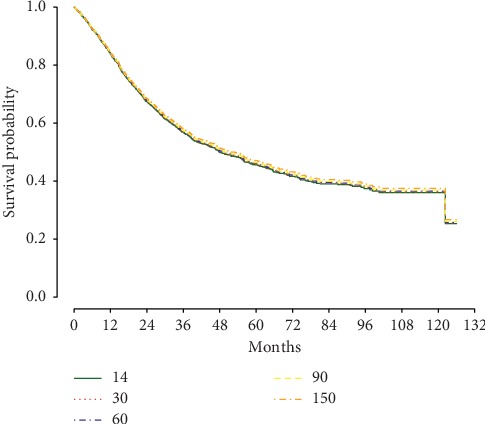
Survival curves using different values for time to treatment initiation. This graph demonstrates the near-identical Kaplan–Meier survival curves when comparing patients with a time to treatment initiation of 14, 30, 60, 90, and 150 days (HR = 1.00; P=0.72).